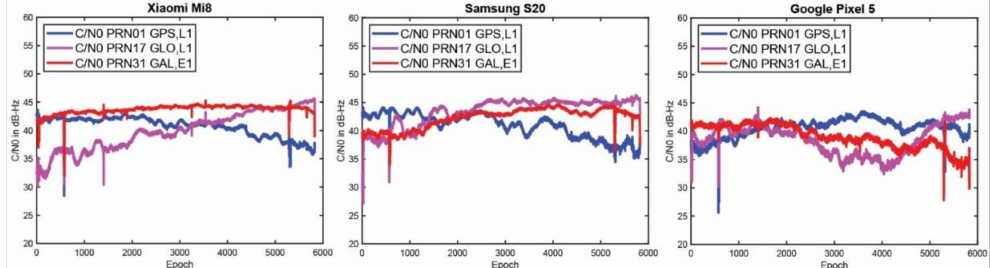
Figure 1. C/N0 measurements for selected PRNs and three smartphone (Xiaomi Mi8, Google Pixel 5 and Samsung S20).